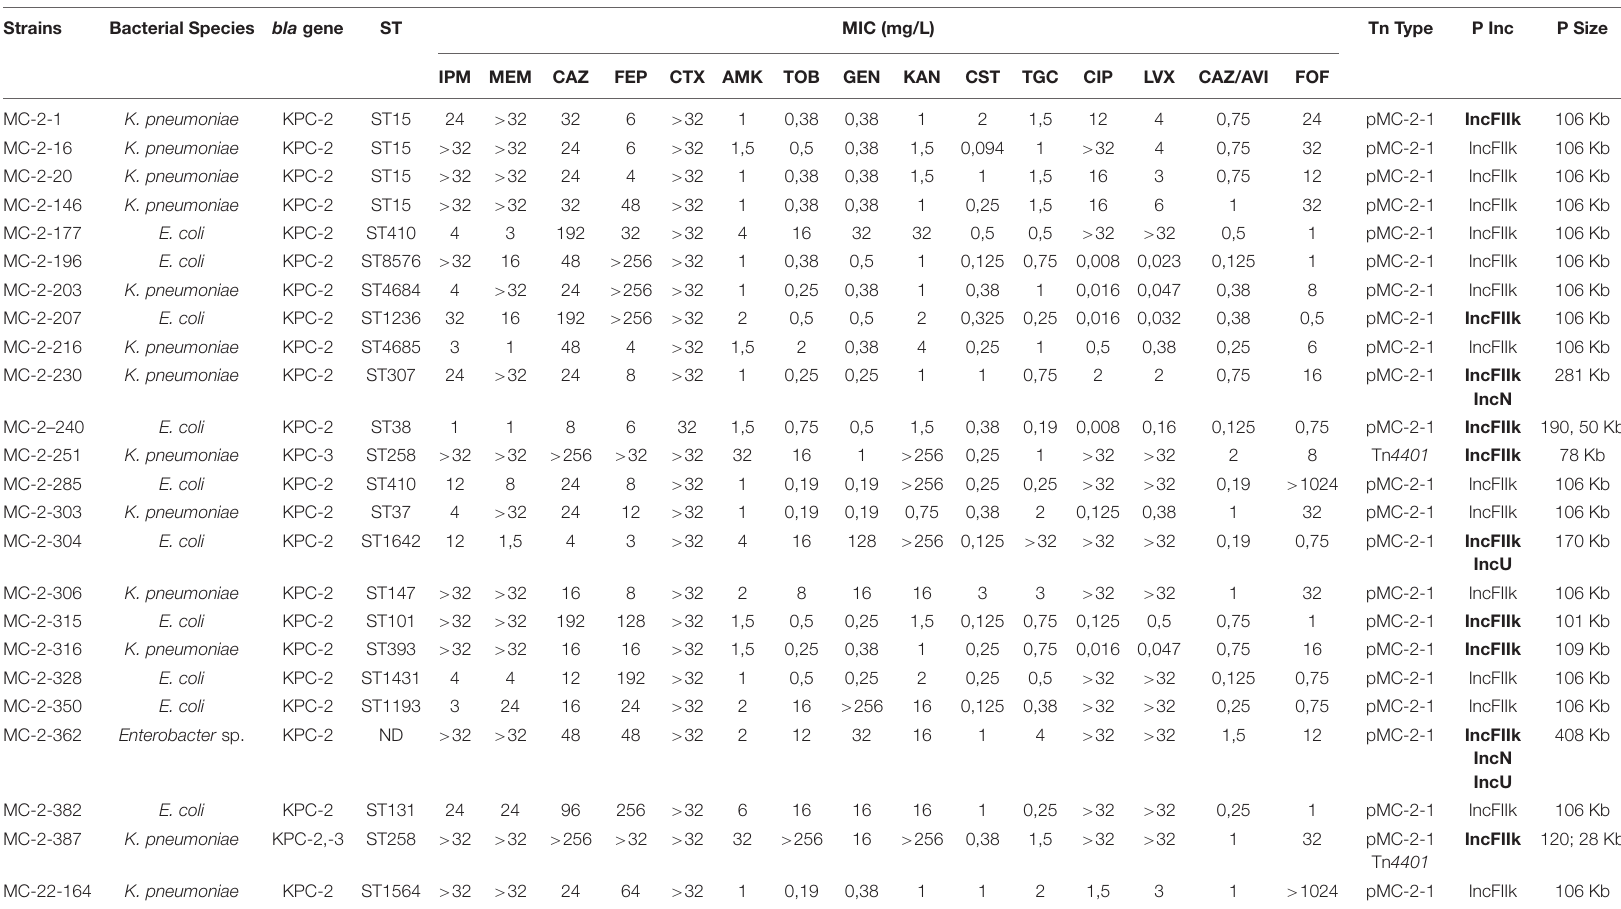
TABLE 1 | Antimicrobial susceptibility and molecular characterization of representative KPC-producing K. pneumoniae , Enterobacter sp. and E. coli isolates. Strains Bacterial Species bla